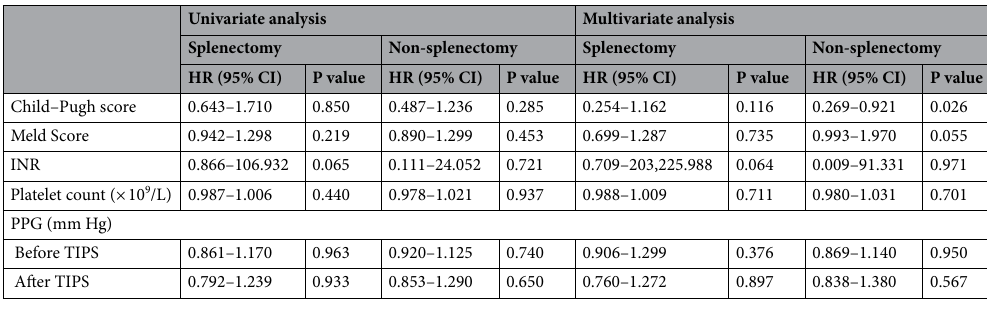
Table 3. Univariate and multivariate analyses according to the incidence of post-bleeding during the observation period in matched group.